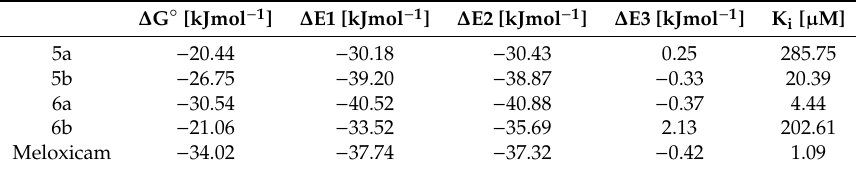
Table 2. Energies of the binding complexes 5a, 6a, 5b, and 6b with COX-2 obtained from molecular docking.